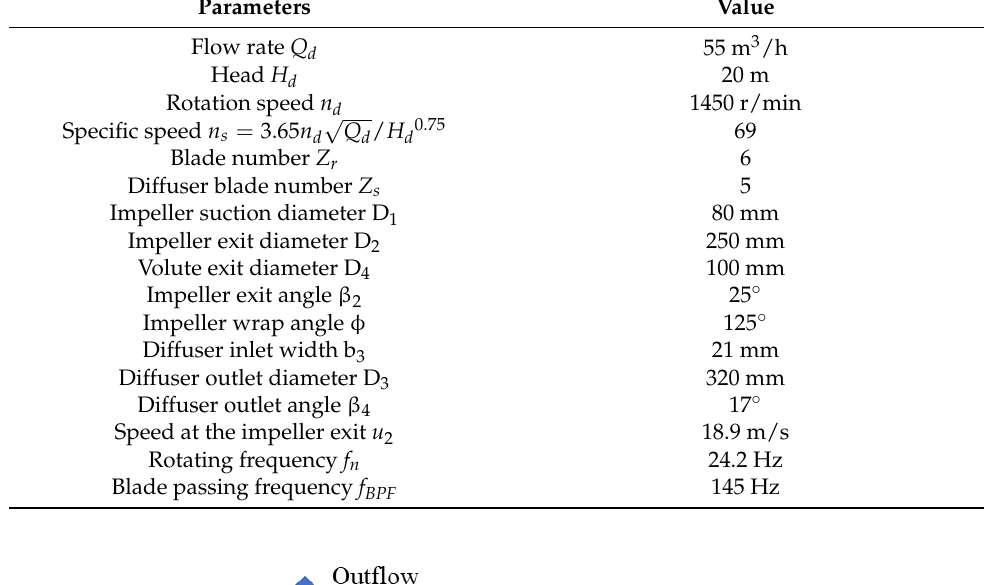
Table 1. The model pump parameters.